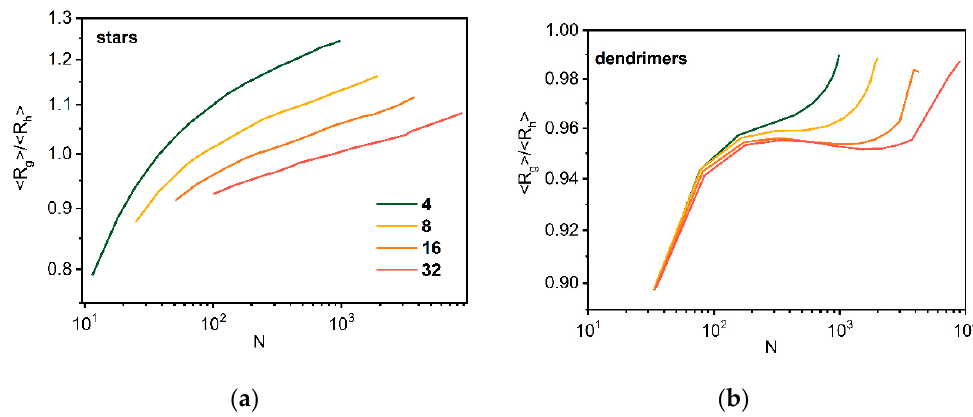
Figure 8. The ratio < R g >/< R h > as a function of total number of beads N for stars ( a ) and dendrimers ( b ). The color indicates the number of macromolecules in the system (see text for